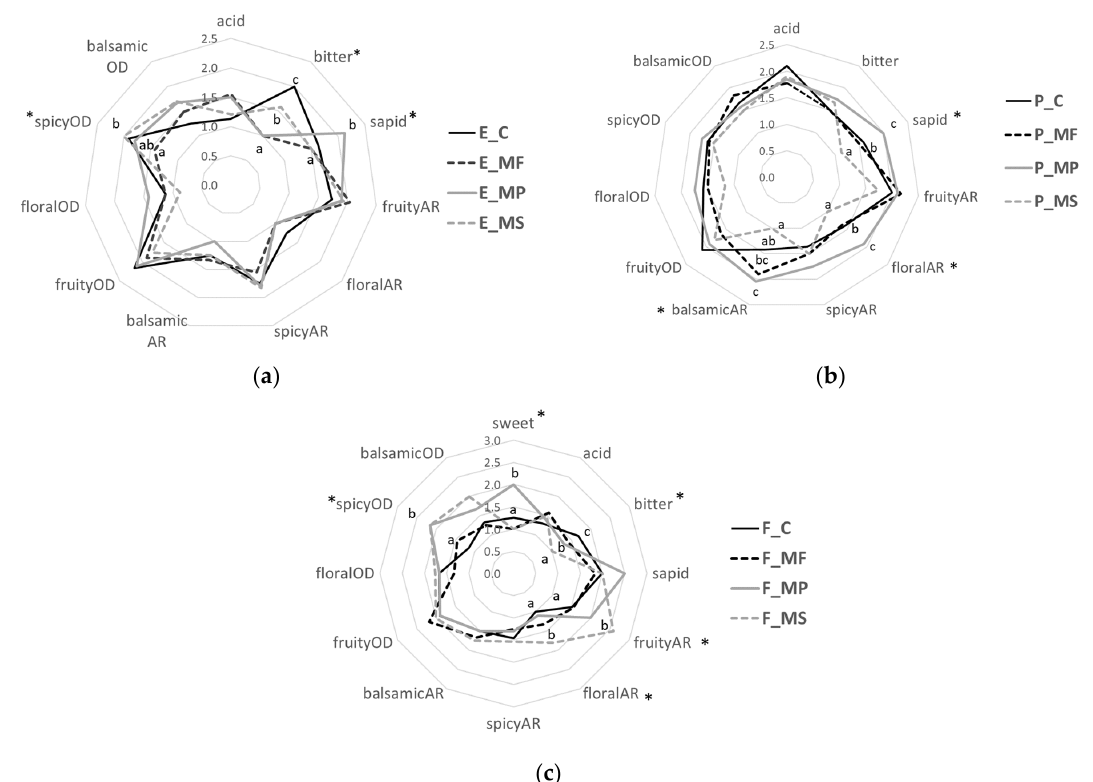
Figure 3. The spider charts representing the tastes, aromas (AR), and odours (OD) of ( a ) extended maceration (E), ( b ) marc- pressed (P), and ( c ) free-run (F) Sangiovese wines after six months of ageing. C represents the control wine. Mannoprotein treatments: MF, MP, and MS at 20 g/hL. The asterisk (*) indicates a statistical difference between wines with different letters according to Duncan’s test ( p < 0.05).